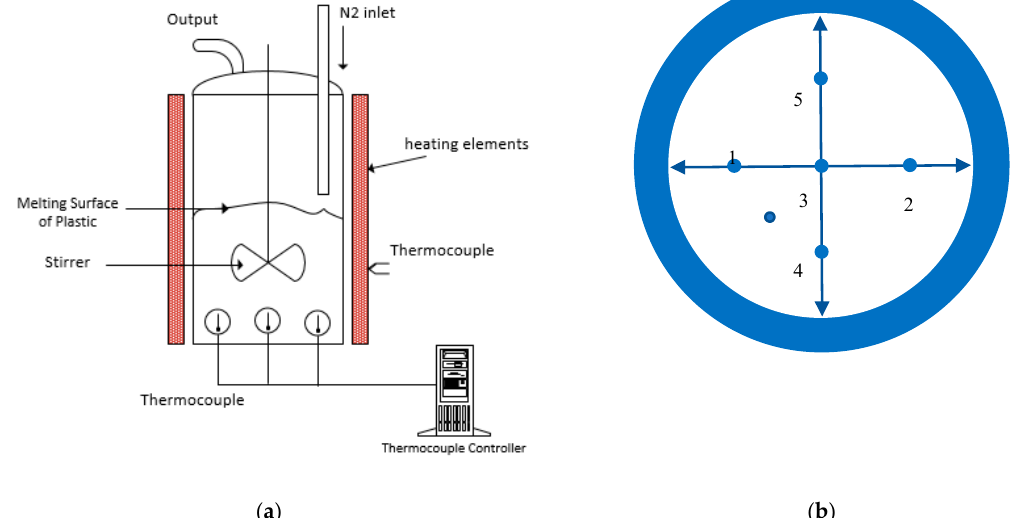
Figure 1. Inner schematics of the co-pyrolysis reactor ( a ), thermocouple configuration at the base of reactor ( b ).